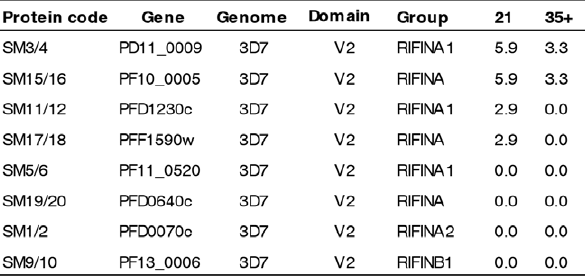
Figure 4. Proportion of malaria naı¨ve volunteers acquiring IgG against RIFIN antigens after controlled experimental P.falci- parum infections. The percentage of malaria infected volunteers with a measurable IgG response against eight RIFIN malaria antigens on day 21 (N=34) and/or day 35, 42 or 90 (N=30) post infection in descending order. The grouping of RIFINs was according to Wang et al. [45]. V2: Variable domain 2, the putative extracellular polymorphic region defined by Cheng et al. [15]. In total 44 volunteers were included (Table S1) and the IgG response was measured by bead-based Luminex